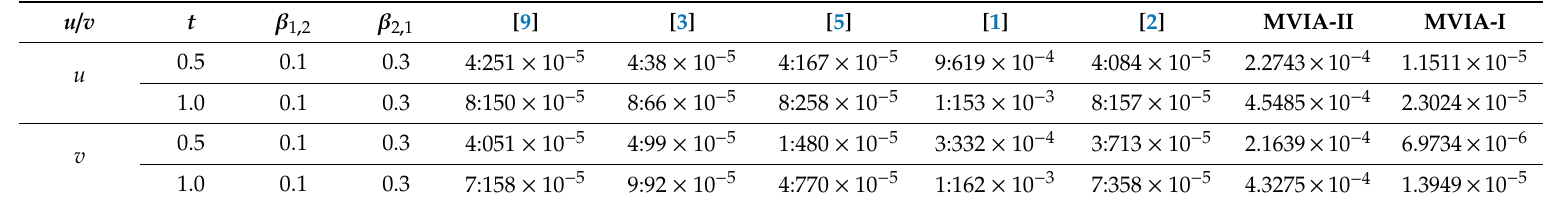
Table 3. Comparison of absolute errors for di ff erent values of t and x for Test Problem